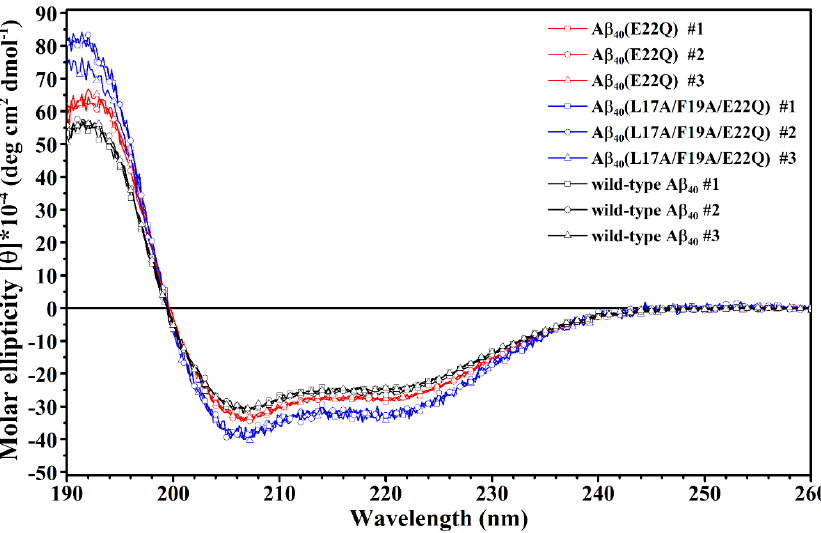
/ F19A / E22Q) β 40 (L17A